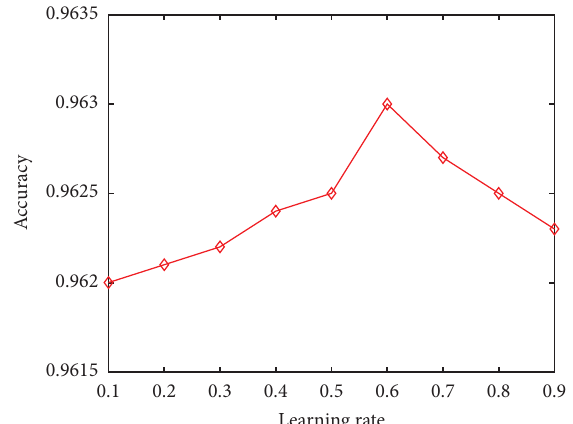
Figure 4: Te efect of diferent learning rates on model training.